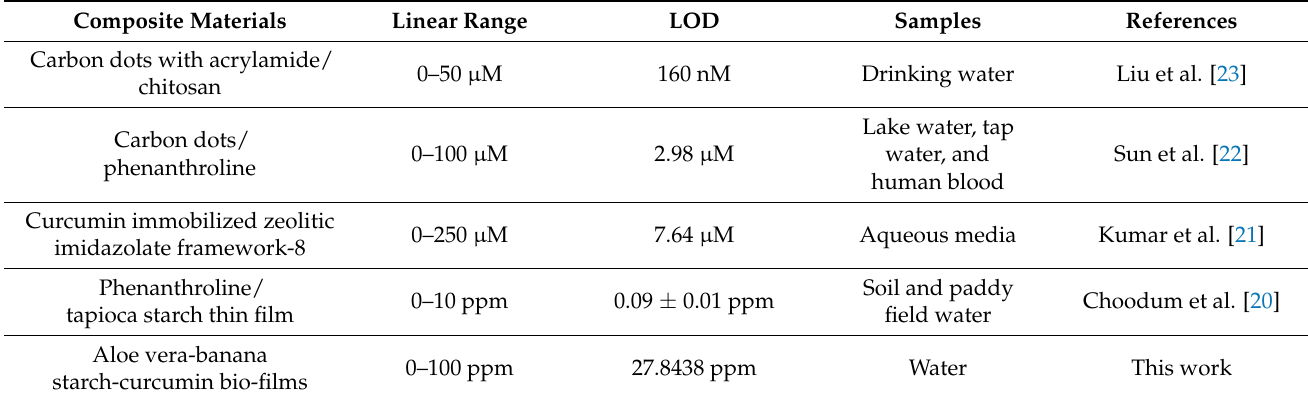
Figure 2. The ( A ) calibration curve of absorbance at a wavelength of 410 nm and ( B ) photograph shows different colors of composite film suspension added with Fe 2+ ions at different concentrations against metal ion standard solution concentration in the range of 0 to 100 ppm at a wavelength of 410 nm (Conditions: ± 25 °C, 45 ± 5% RH; Response time: 10 s). Table 3. Comparison of different composite materials to determine Fe 2+